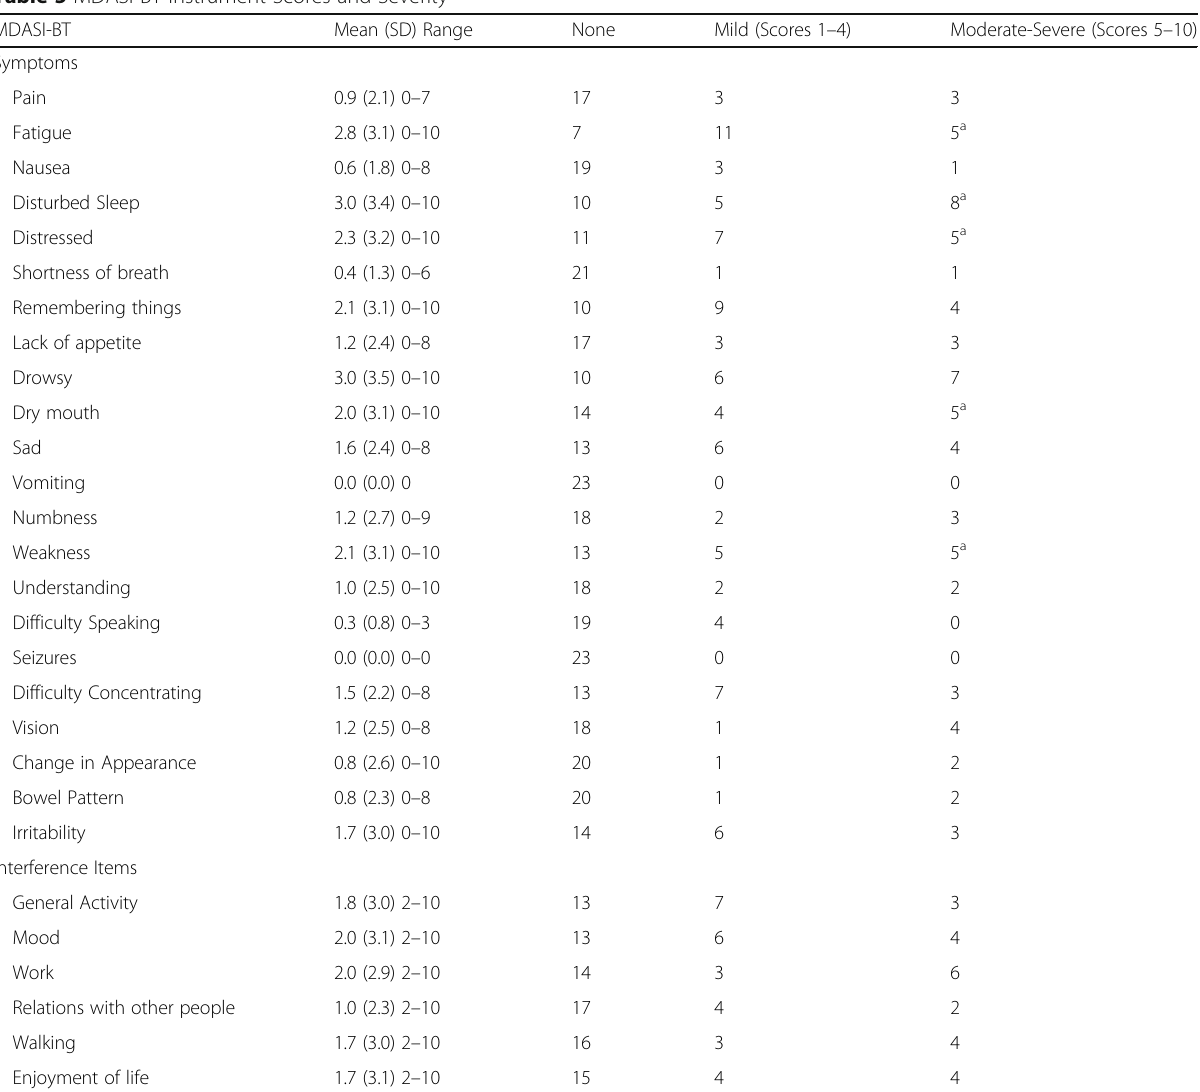
Table 5 MDASI-BT Instrument Scores and Severity